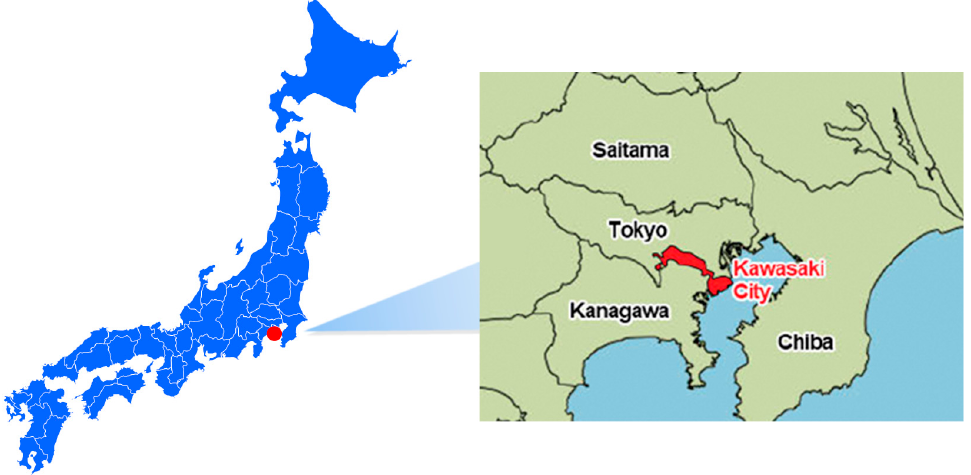
Figure 1. Location of Kawasaki City in Japan.